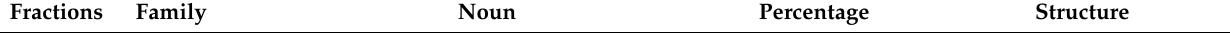
(*) Means ± standard error in a row, followed by the same lower case letter (a, b, c, d) are not significantly different ac ‐ cording to SNK test at p ≤ 0.05. Table 8. Glucosinolate degradation products in the fractions identified by Gas Chromatography Analysis (GCA). Fractions Family Noun Percentage